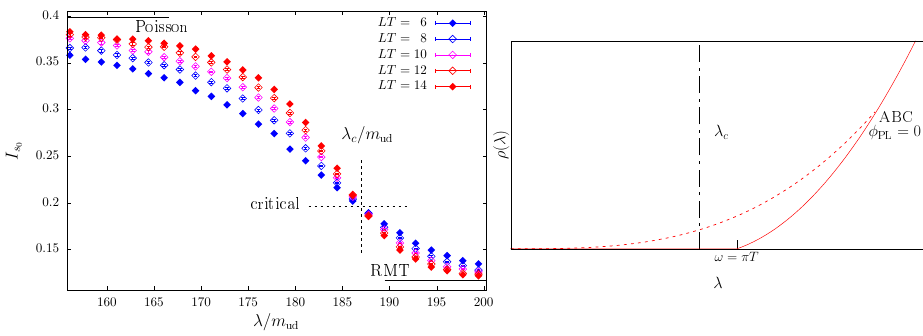
Figure 1. Left: I s [see Eq. (5)] along the Dirac spectrum (in units of the light-quark mass m ud ) for 2 + 1 0 flavour lattice QCD at T = 394 MeV, for several spatial sizes L (here the lattice spacing is a = 0 . 125 fm, and s 0 (cid:10) 0 . 508). The mobility edge, the critical value of the statistics, as well as the Poisson and RMT expectations are also shown. (Data from Ref. [8].) Right: Sketch of the spectral density in high- temperature QCD (ˆ μ I = 0). The solid line is the spectral density in the case of vanishing gauge fields, starting at the gap ω = π T , while the dashed line qualitatively shows the spectral density after the inclusion of localised modes penetrating the gap, and λ c indicates the position of the mobility